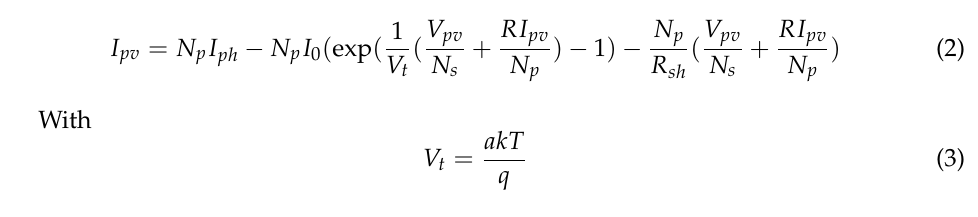
Figure 2. Equivalent circuit of solar module.